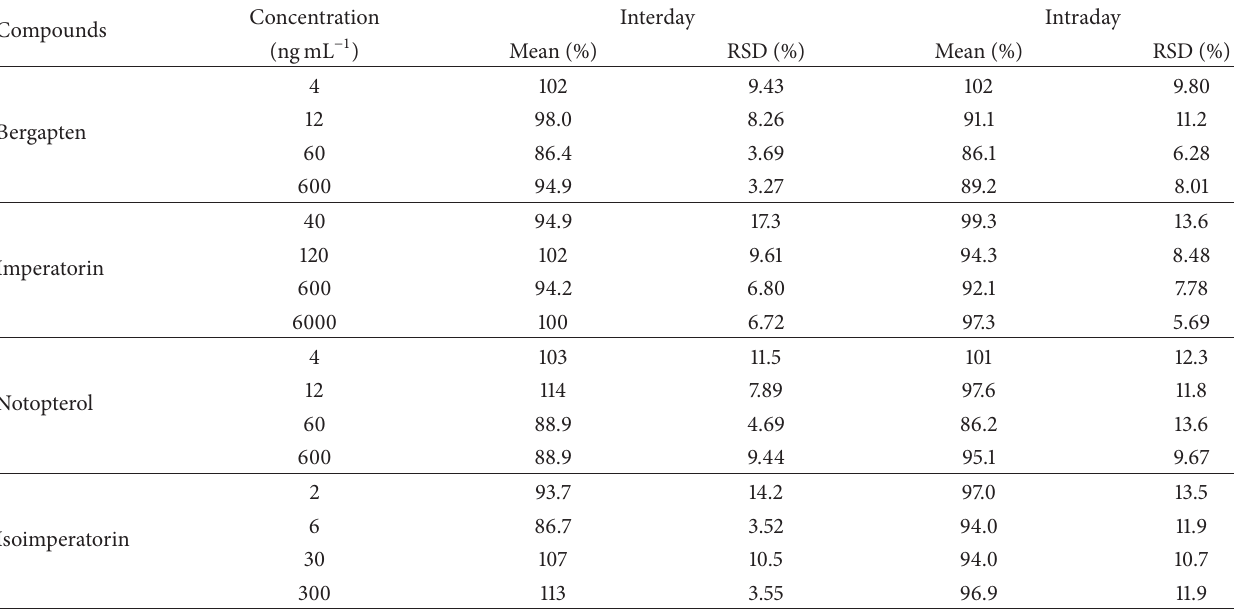
Table 3: Intraday, interday accuracy, and precision ( 𝑛 = 6 ).